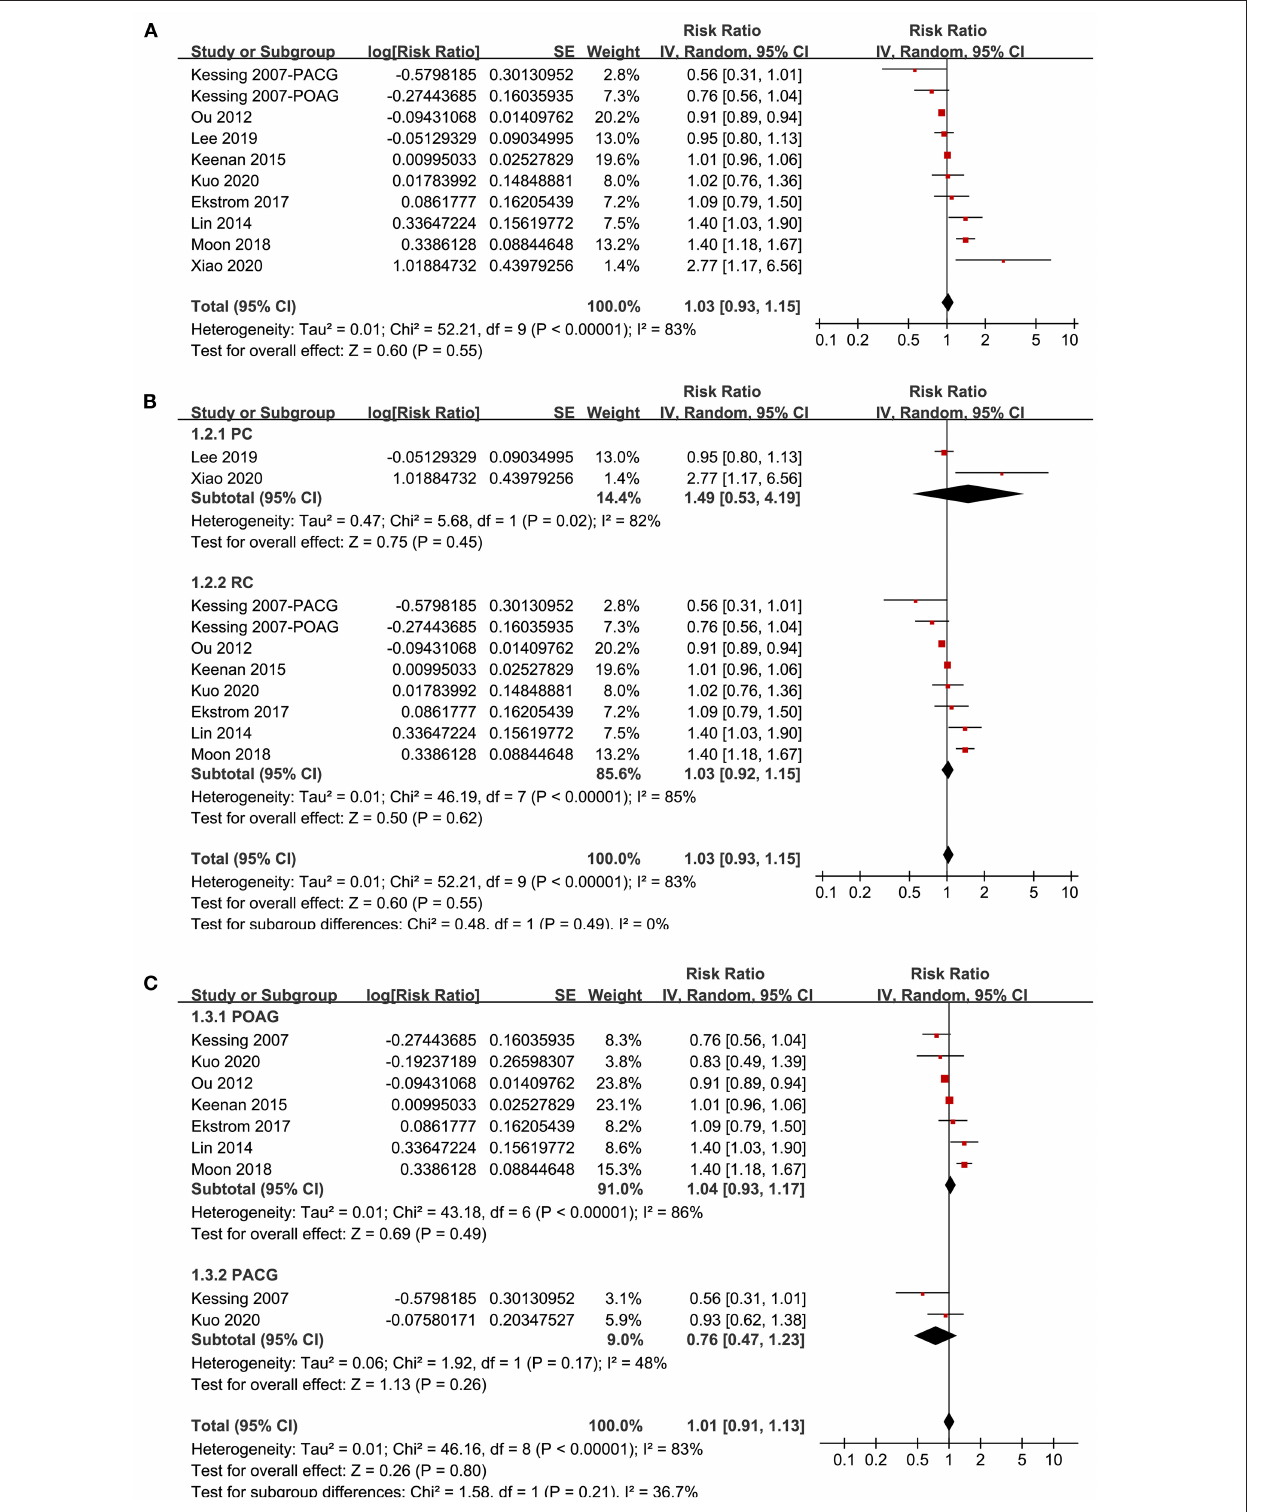
Frontiers in Medicine |